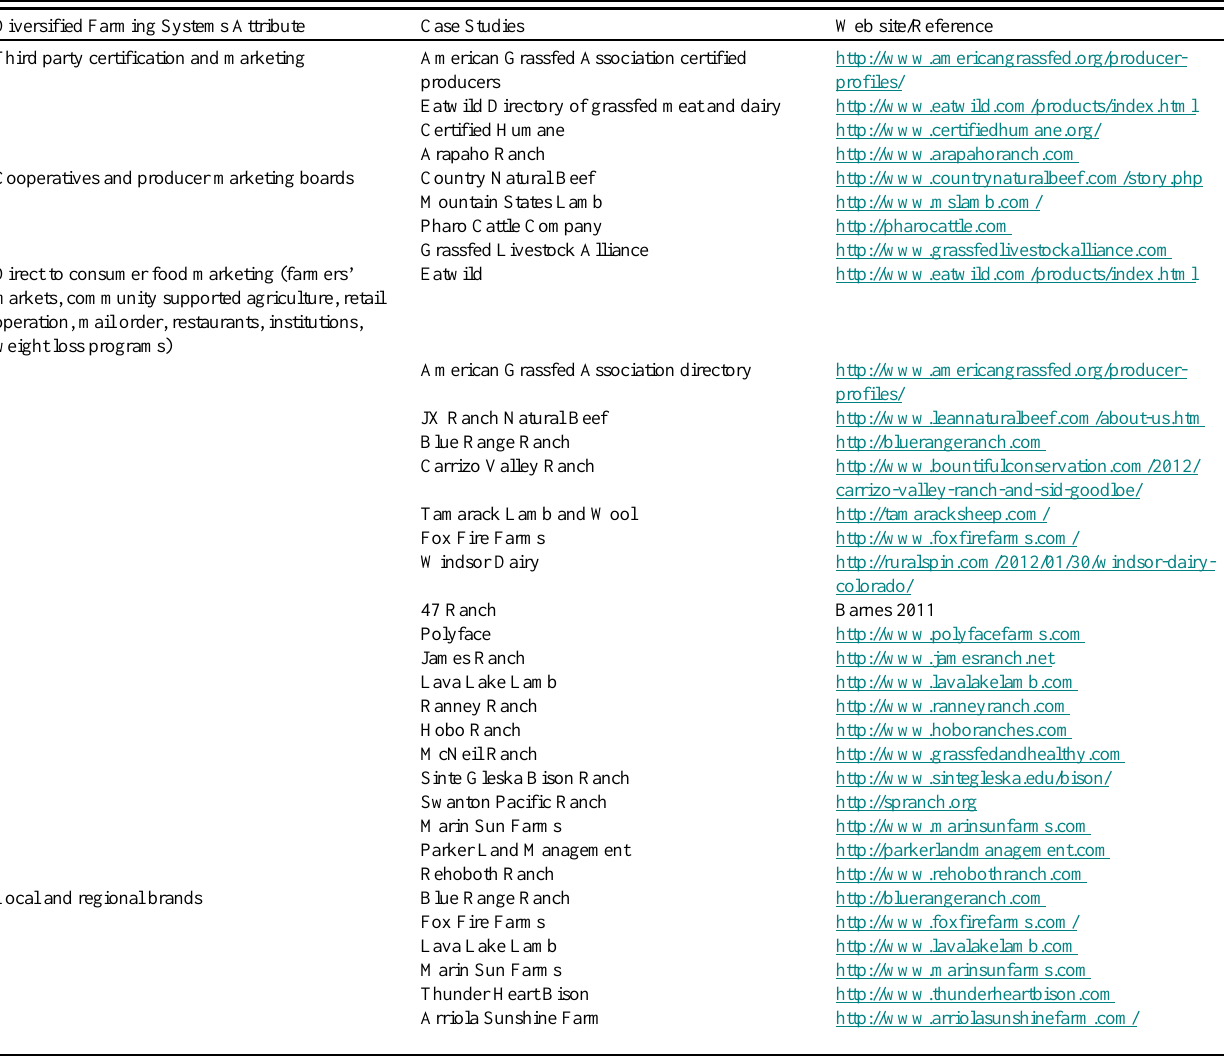
Table 4 . Diversification of markets and